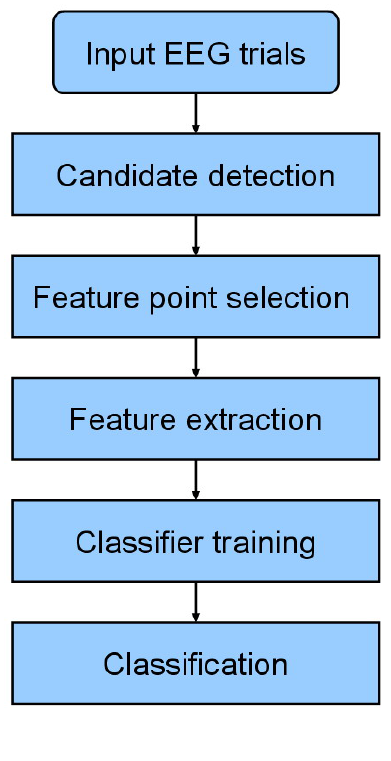
Figure 1. Flowchart of the proposed